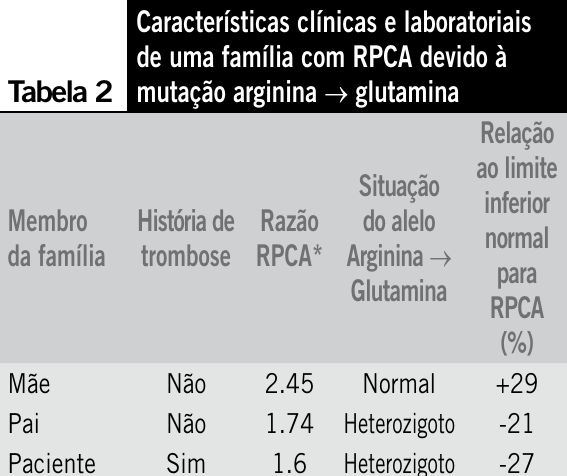
Figura 2 – Pesquisa da mutação G20210A da protrombina no paciente com trombose venosa profunda e em seus pais. Raia 1: marcador de peso molecular; raia 2: mãe; raia 3: pai. raia 4: paciente, raia 5: controle-negativo; raia 6: não-digerido; raia 7: água Milli Q